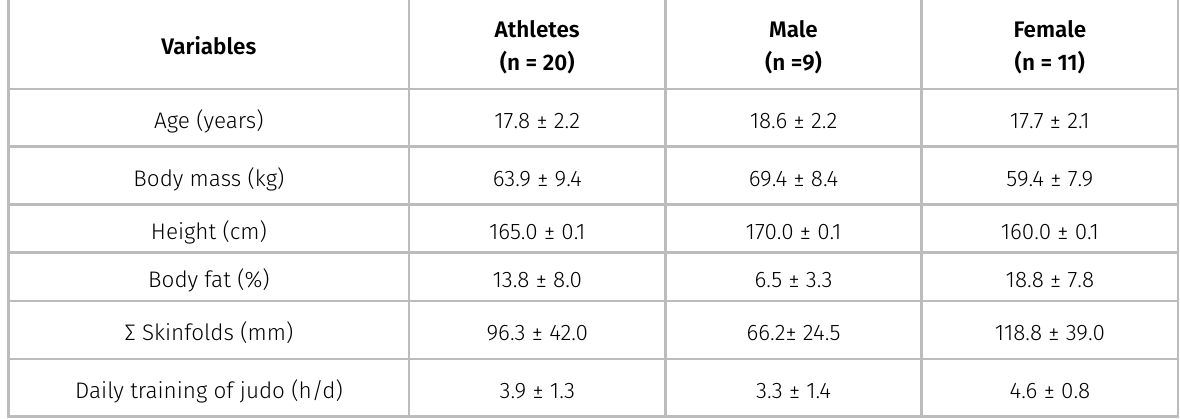
Table I. Characteristics: age, body composition and training of judo athletes.